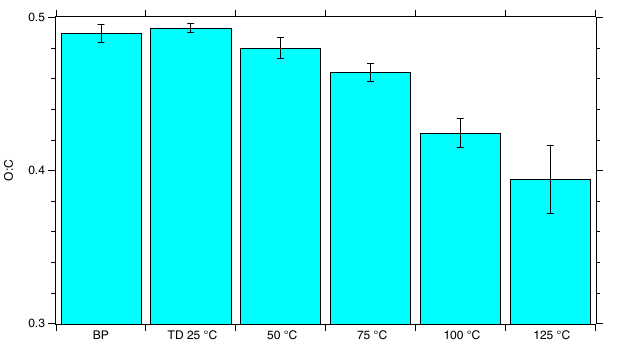
Figure 5. (a) The average activation diameter observed at 0.2% supersaturation in the CCNC for Experiment 1. The error bars rep- resent 1 standard deviation of the mean. (b) The estimated κ values for Experiment 1. The error bars were obtained by estimating the κ at ± 1 standard deviation of the average activation diameter mea- sured. The values at TD temperatures of 75 ◦ C and greater were statistically different from the values at the BP and the TD at 25 ◦